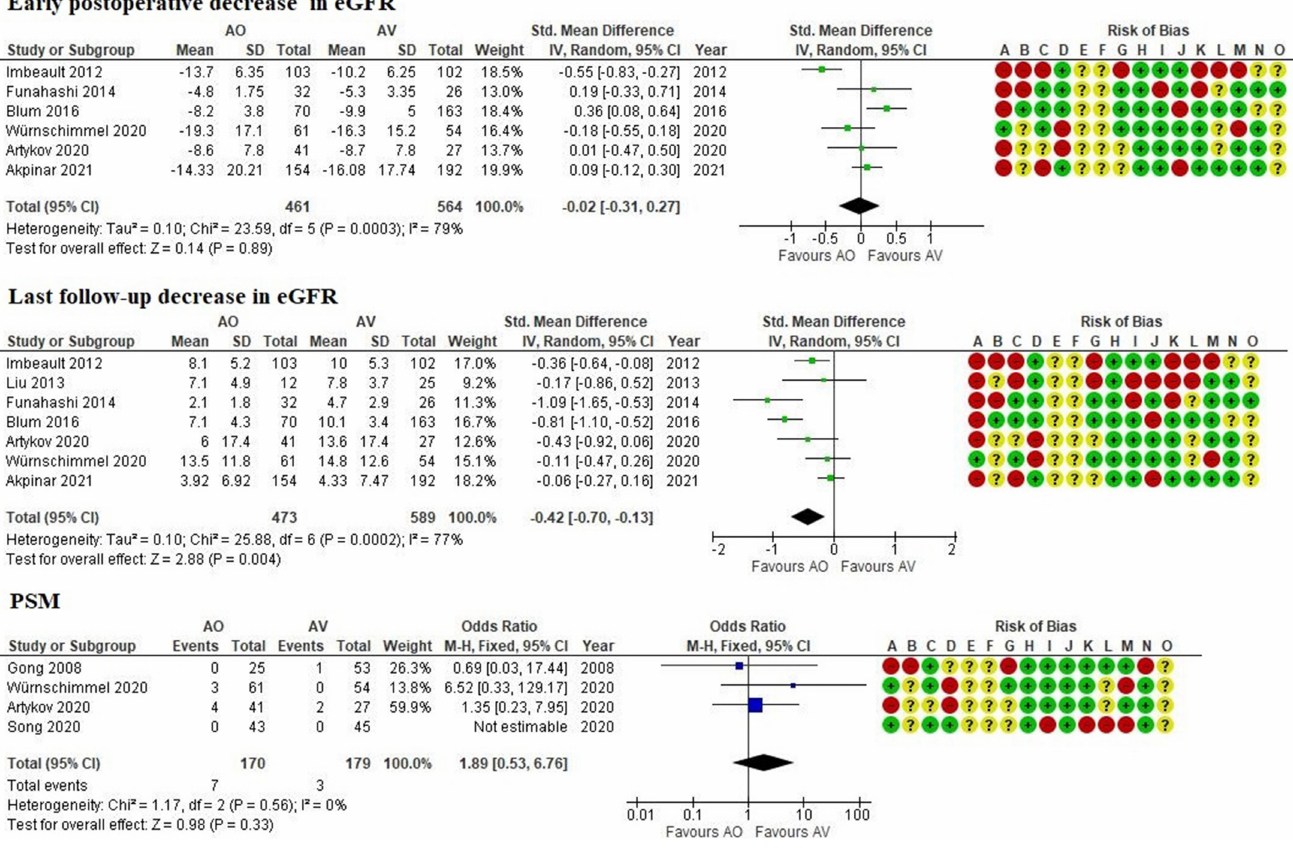
Figure 6. Meta-analysis of postoperative change in eGFR and positive surgical margin. (A) random sequence generation/balanced groups; (B) allocation concealed/unrelated to confounders; (C) comparable groups at baseline; (D) Equal care except for intervention; (E) blinding participants; (F) blinding carers; (G) equal follow-up; (H) treatment completion; (I) available data of postoperative complications; (J) available data of transfusion rate; (K) available data of CKD; (L) Appropriate length of follow-up; (M) precise definition of outcome; (N) valid reliable outcome assessment; (O) blinding of investigators. CKD, chronic kidney disease; eGFR, estimated glomerular filtration